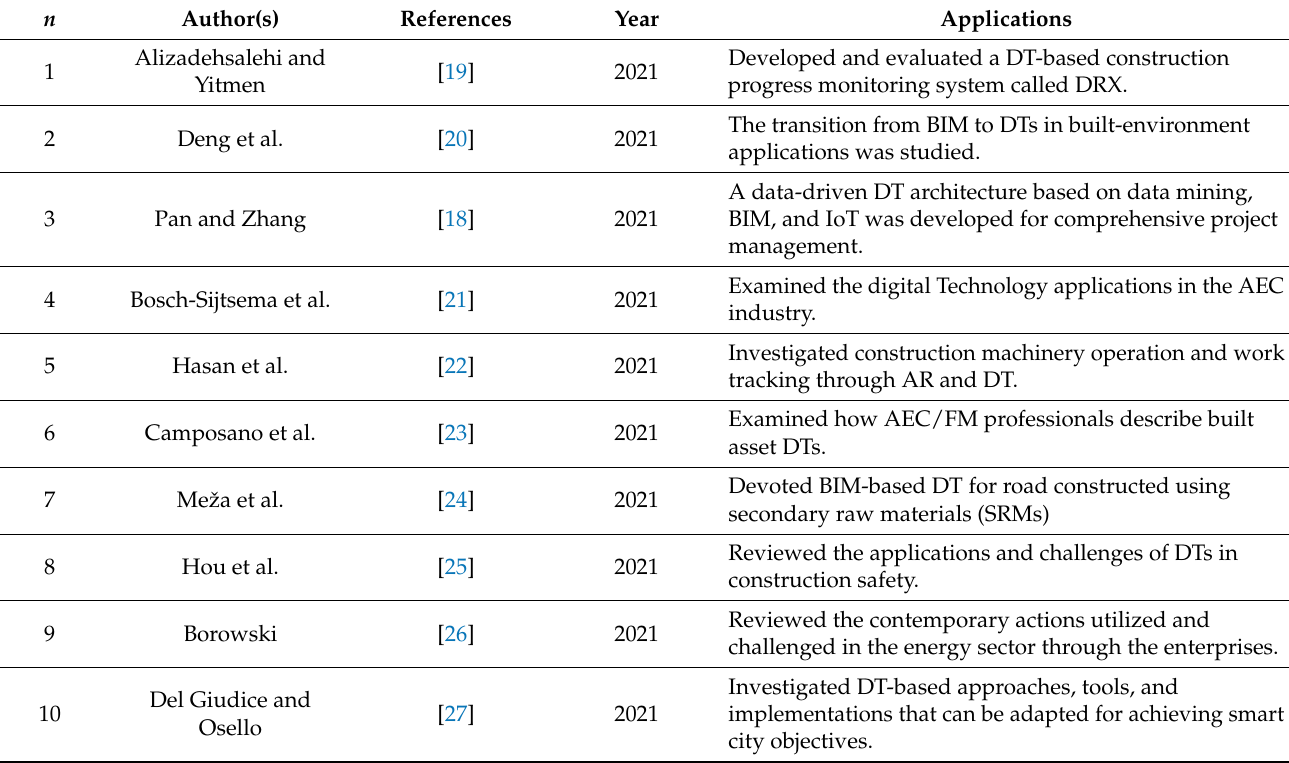
Table 1. Digital Twins applications in the AEC industry that appeared in the recent